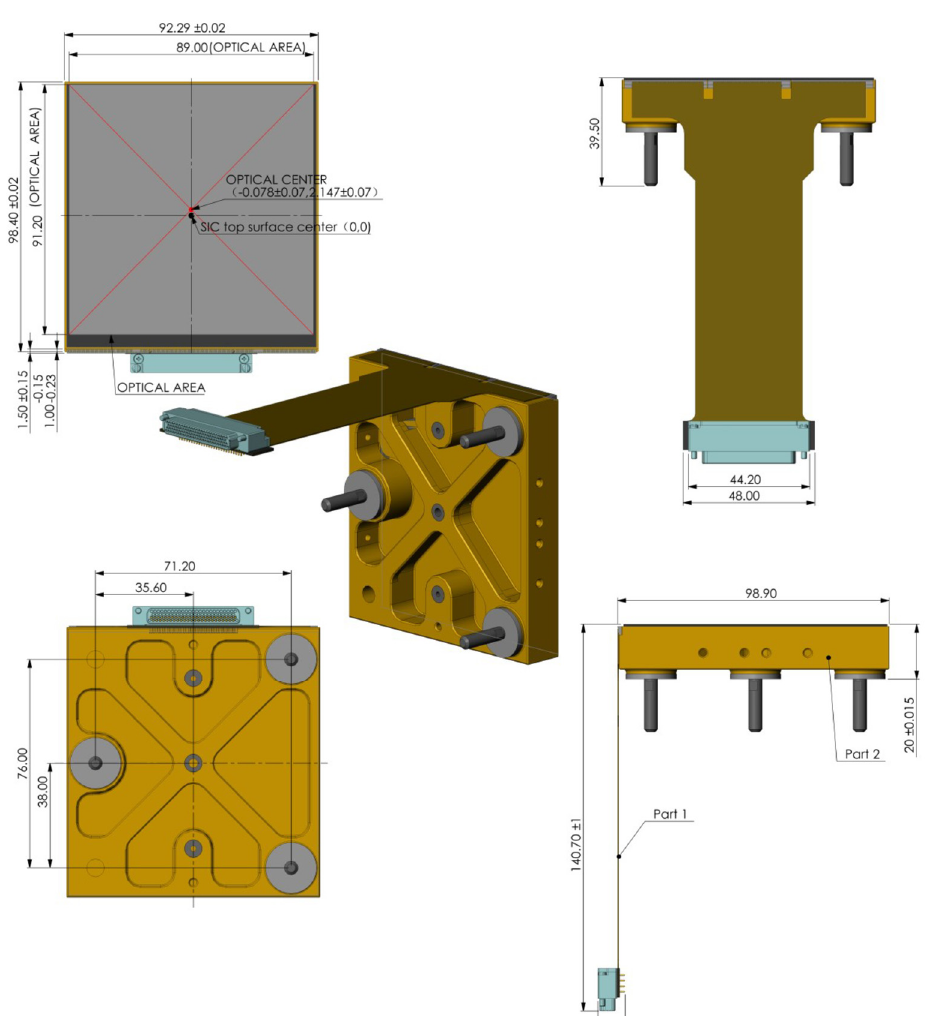
Figure 2. 9 K × 9 K CMOS detector model.